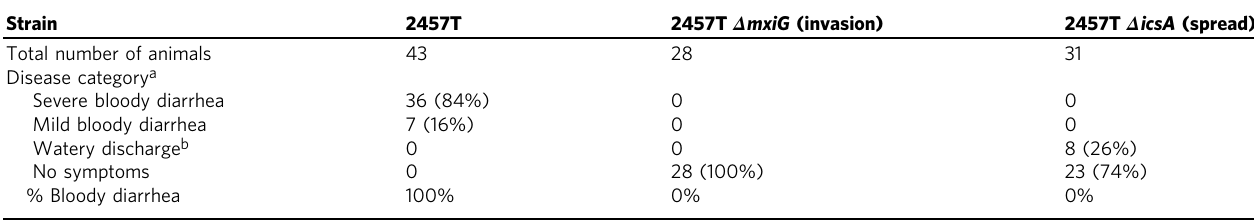
Table 1 Bacillary dysentery in infant rabbits inoculated with wild-type and mutant S. fl exneri